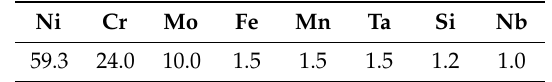
Table 1. Chemical composition of the Heraenium ® NA alloy (wt.%).